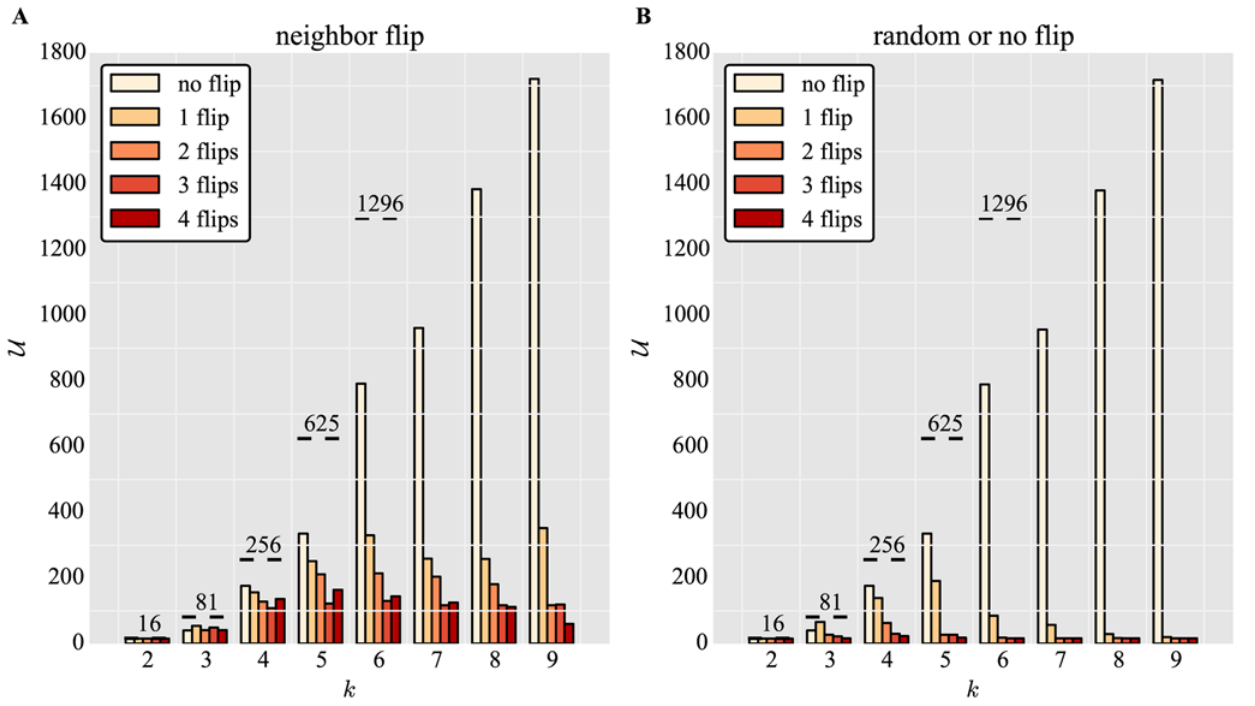
Fig 5. Effect of implementations of noise on phenotype discovery for varying k and N = 4. Number of unique phenotypes U accessed for different different numbers of gene expression states k , and varying number of gene flips for noise models (A) neighbor flip and (B) random or no flip. Networks are random (not pre-selected for stability). Other parameters and dashed lines are as in Fig